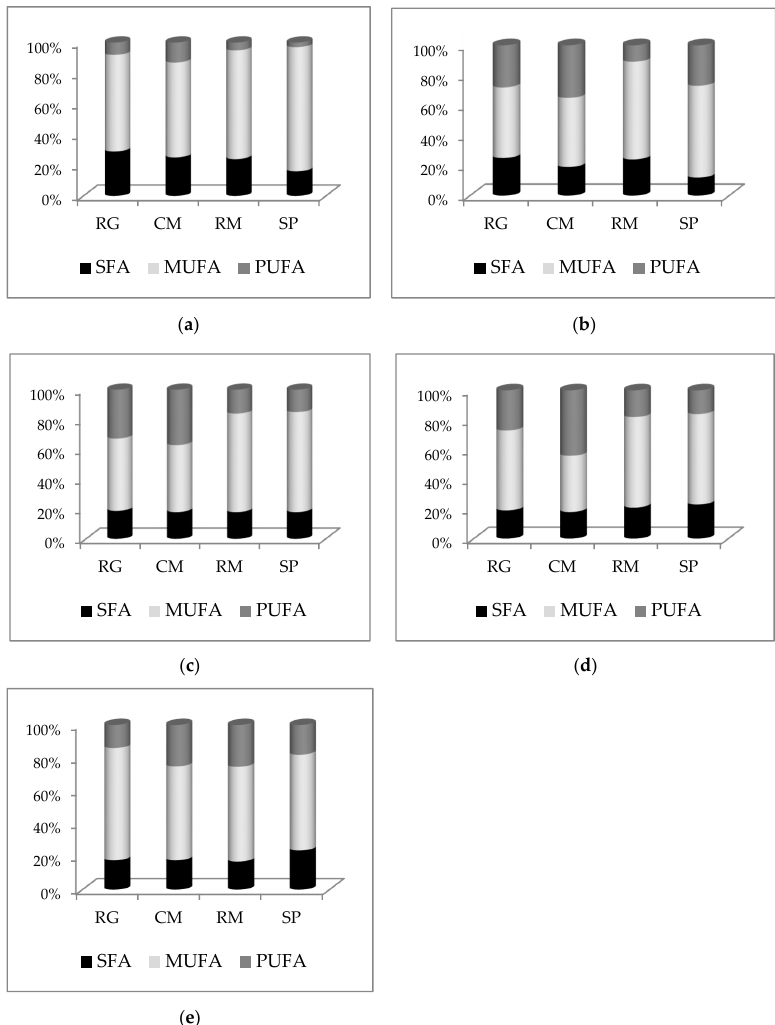
Figure 7. Fatty acid composition of total lipid fraction after 96-hour cultivation in different media. ( a ) Medium with glucose; ( b ) Medium with glycerol; ( c ) Medium with crude animal fat; ( d ) Medium with emulsified fat; ( e ) Medium with enzymatically hydrolyzed fat. Abbreviations: RG ( Rhodotorula glutinis CCY 20-2-26), CM ( Cystofilobasidium macerans CCY 10-1-2), RM ( Rhodotorula mucilaginosa CCY 19-4-6) and SP ( Sporobolomyces pararoseus CCY 19-9-6). SFA, saturated fatty acids; MUFA, monounsaturated fatty acids; PUFA, polyunsaturated fatty acids.